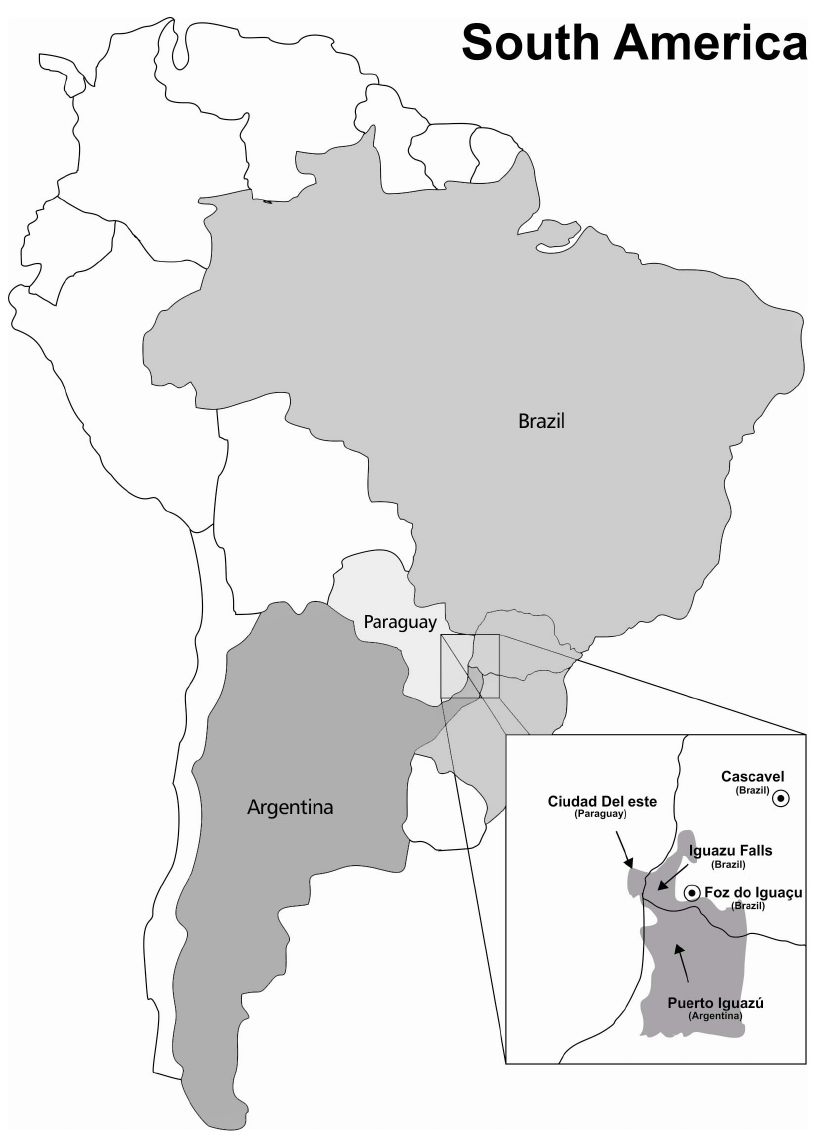
Figure 2. The triple border Brazil/Paraguay/Argentina, with the location of the cities of Foz do Iguacu and Cascavel (Brazil), Ciudad del Este (Paraguay) and Puerto Iguazu ´ (Argentina).